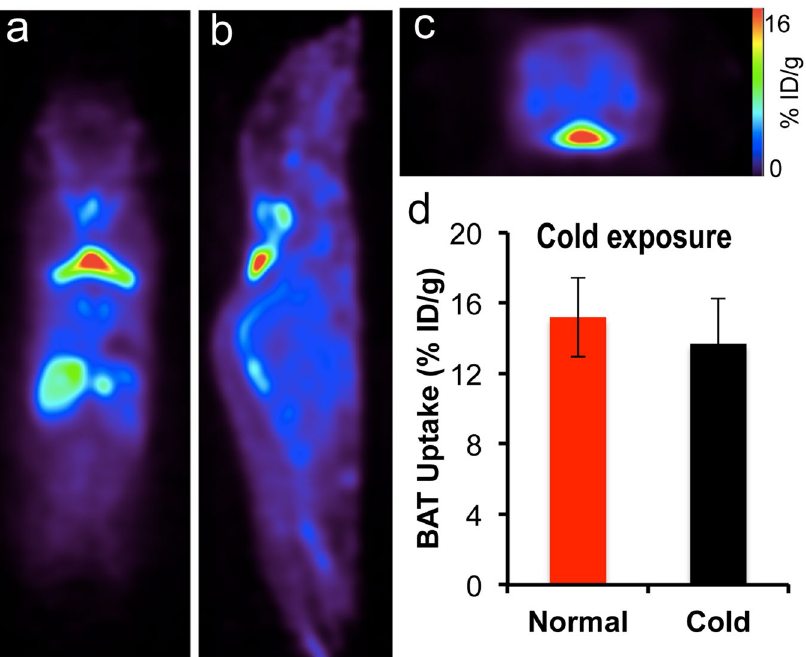
Figure 5. Representative PET images of mice injected with [ 18 F]-F-DPA. ( a ) Coronal view, ( b ) sagittal view, and ( c ) transverse view. The triangular shape of BAT can be clearly identified. ( d ) Quantitative analysis of BAT uptake under normal and cold exposure. There was no significant difference between these two groups (p =